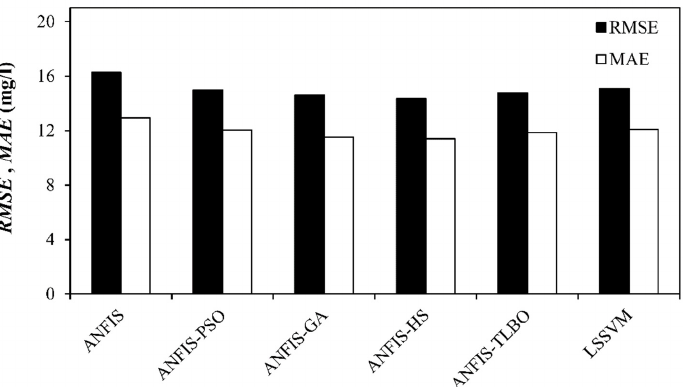
Figure 7. Visual comparison of model performance for the best input combination and data set.